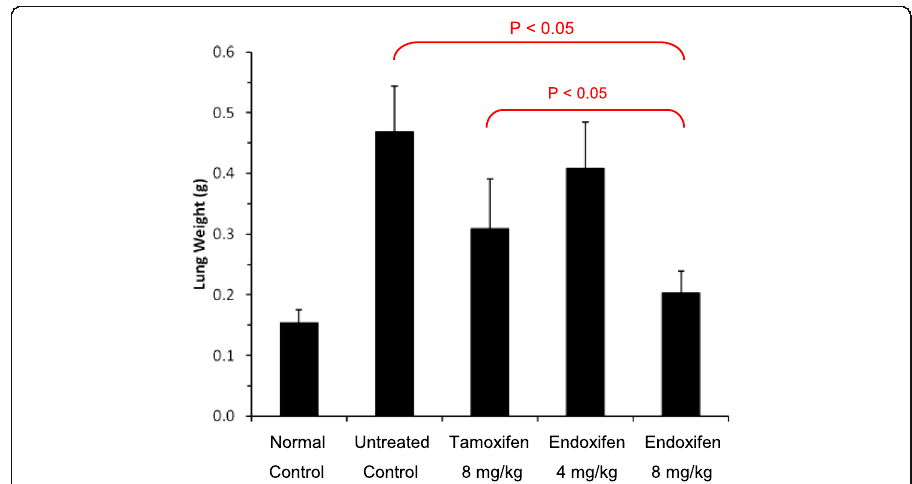
Fig. 3 Comparative lung weights of normal, untreated and drug-treated melanoma mice. Treatment with endoxifen or tamoxifen at a dose of 8 mg/kg body weight significantly reduced lung weight of mice with melanoma ( p < 0.05). The data represent the means ± SD, ( n =